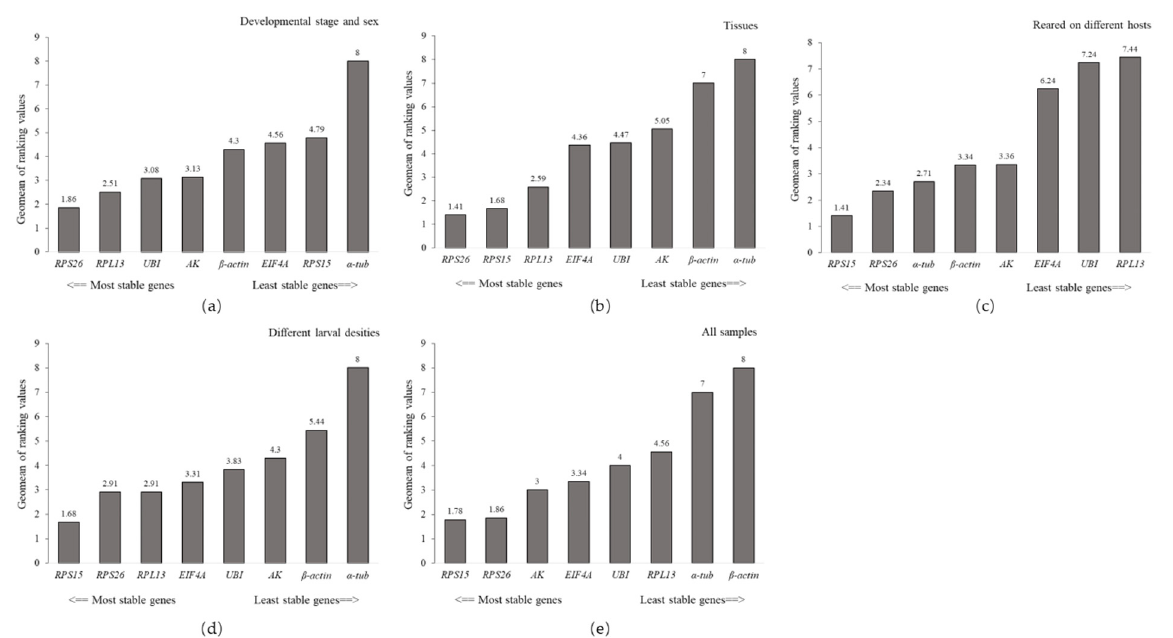
Figure 2. The stability of the eight candidate reference genes was evaluated by the RefFinder. ( a ) Developmental stages and gender. ( b ) Different tissues. ( c ) Larva feeding on different hosts. ( d ) Different larval densities. ( e ) All samples.